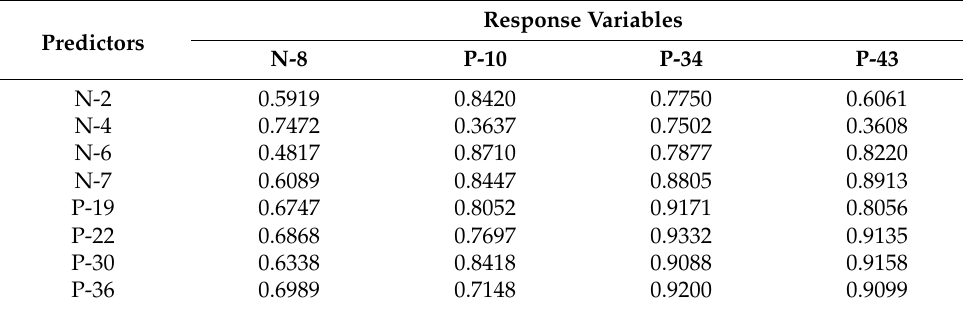
Table 3. Correlation coefficients between response variables and their